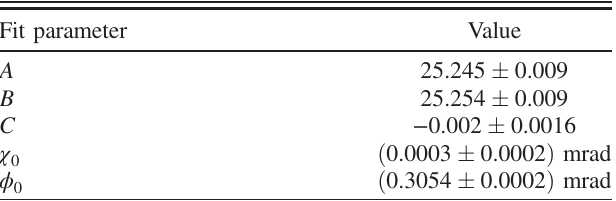
TABLE VIII. Fit parameters obtained using Eq. (115) on the simulation data shown in Fig. 22(b), using factor F ¼ 10 20